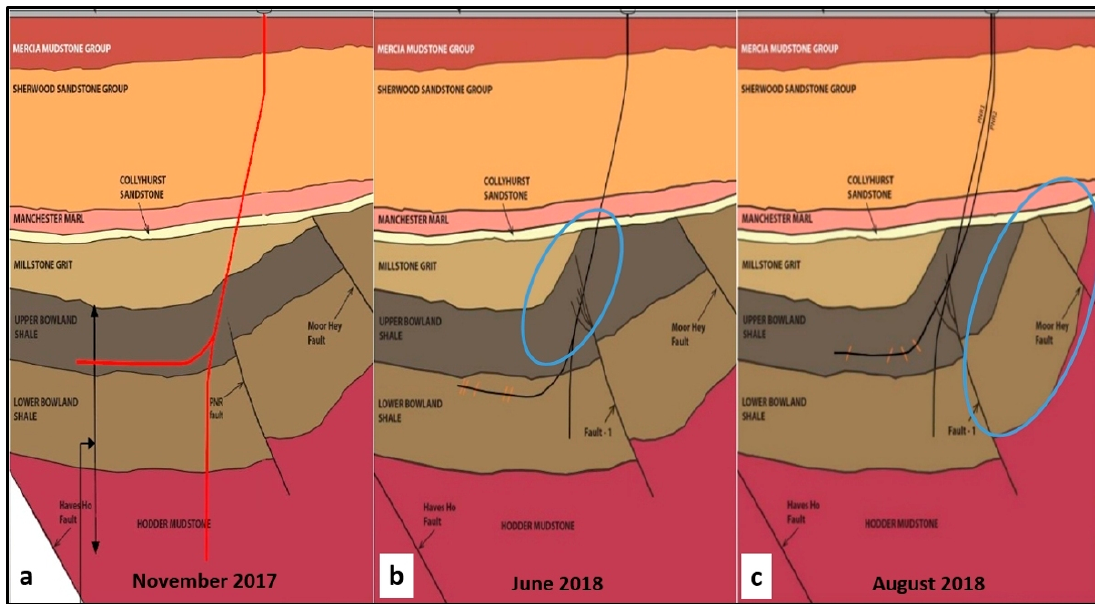
Figure 9. East–west cross-sections through Preston New Road by Cuadrilla in support of its hydraulic fracture plans, showing progressive changes to the geological interpretation. ( a ) November 2017; proposed PNR-1 and 1z (shown in red), prognosed to penetrate 300 m of Millstone Grit (buff). ( b ) June 2018; revised interpretation (blue ellipse) to explain absence of Millstone Grit at the well (black line). ( c ) August 2018; further revision of the geology (blue ellipse) for the PNR-2 HFP, to minimise the unrealistic thickness variations of the Bowland Shale shown in ( b ). Interpretations ( b ) and ( c ) are arrived at by ‘photoshopping’ the original image ( a ), and are not based upon geological re-interpretation of the seismic dataset. The original images have been slightly compressed horizontally.